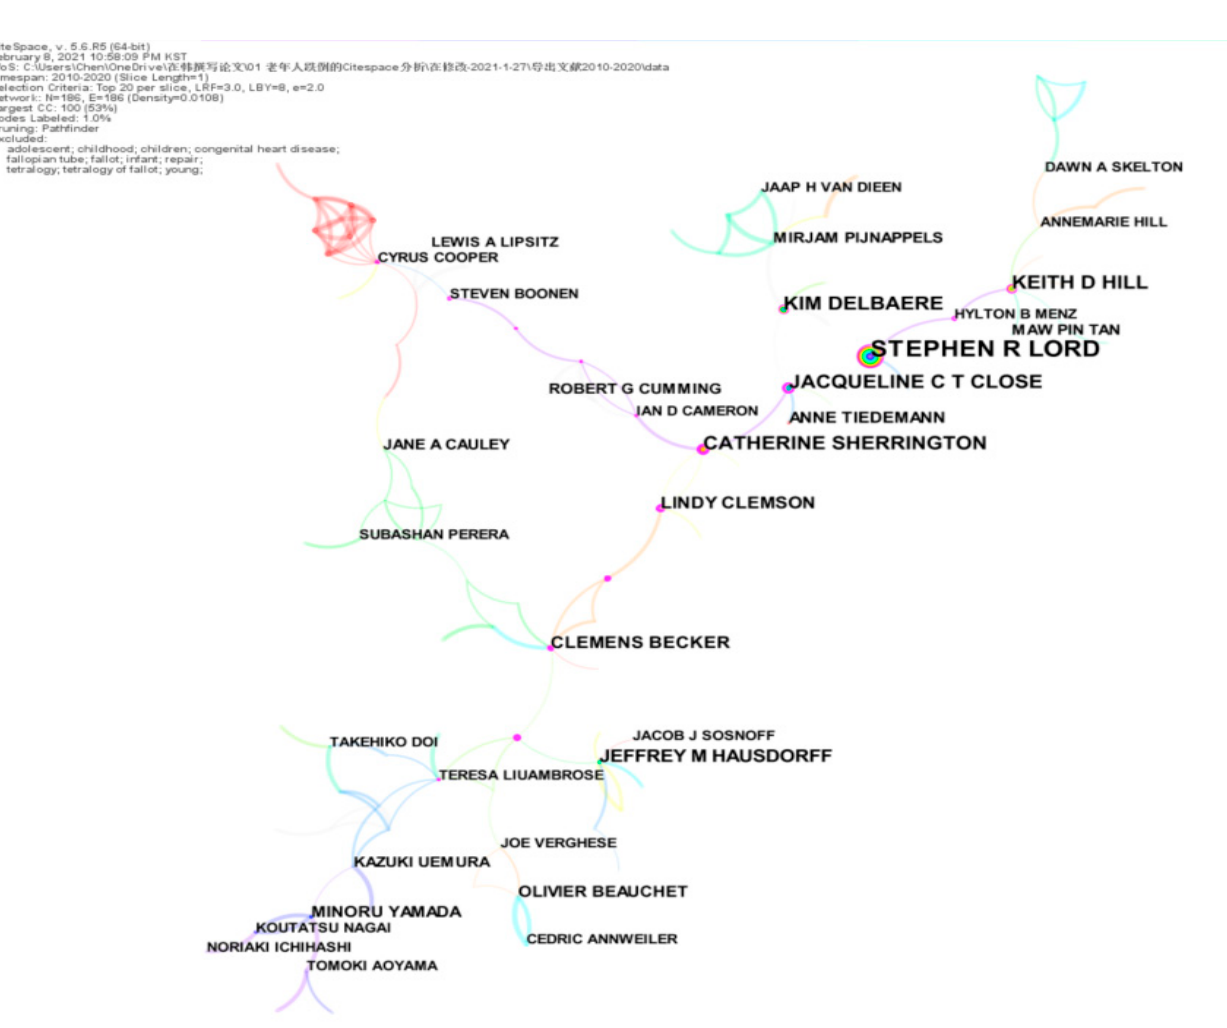
Table 2. Author rank in different conditions.